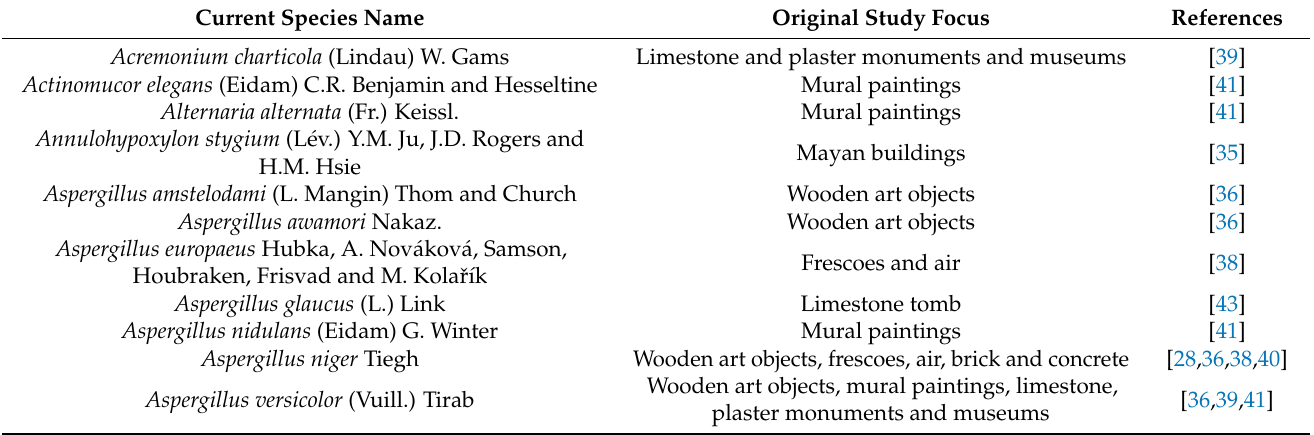
Table 1. Overview of fungal species for which isolates have been identified as having CaCO 3 dissolution abilities in biodeteriorative plate